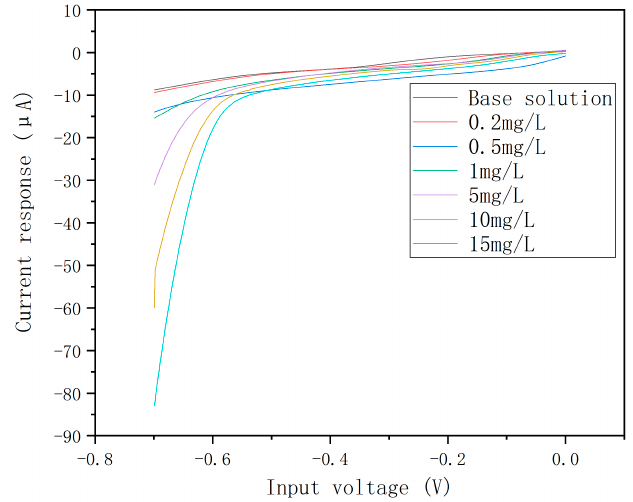
Figure 6. The linear sweep voltammetry plots for the nitrate of the chips modified by Pd-AuNPs composite sensing film.